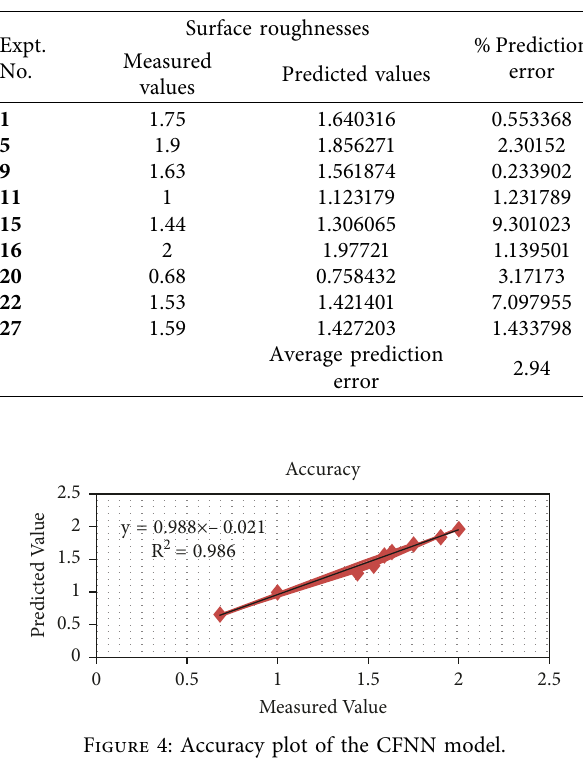
Figure 3: Performance plot of the CFNN model. Table 6: Percentage prediction error.